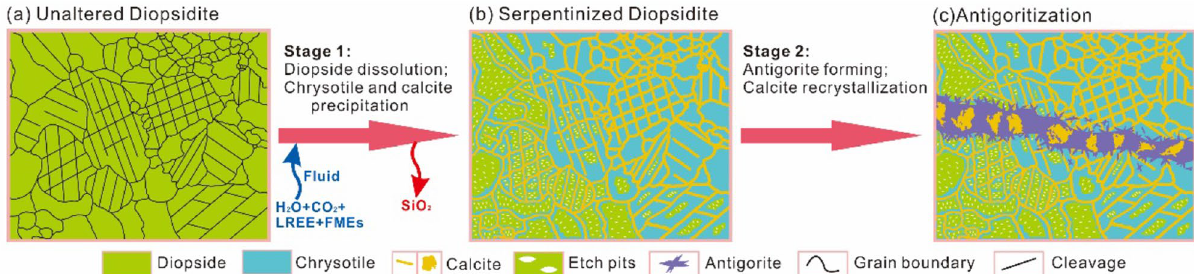
Figure 9. Sketch representing the formation processes of the studied serpentinized diopsidite. ( a ) Fresh diopsidite with abundant cleavages. ( b ) CO 2 -rich fluids flow along the grain boundaries and cleavages of diopsides. Diopsides dissolve to form abundant etch structures (e.g., etch pits); simultaneously, calcite and chrysotile nucleate and grow around the etch peaks. Then, diopsides are completely altered by calcite and 2 O, CO 2 , LREEs, and FMEs but lose SiO 2 . ( c ) Serpentinized diopsidite further undergoes antigoritization that results in the formation of antigorite and coarse-grained